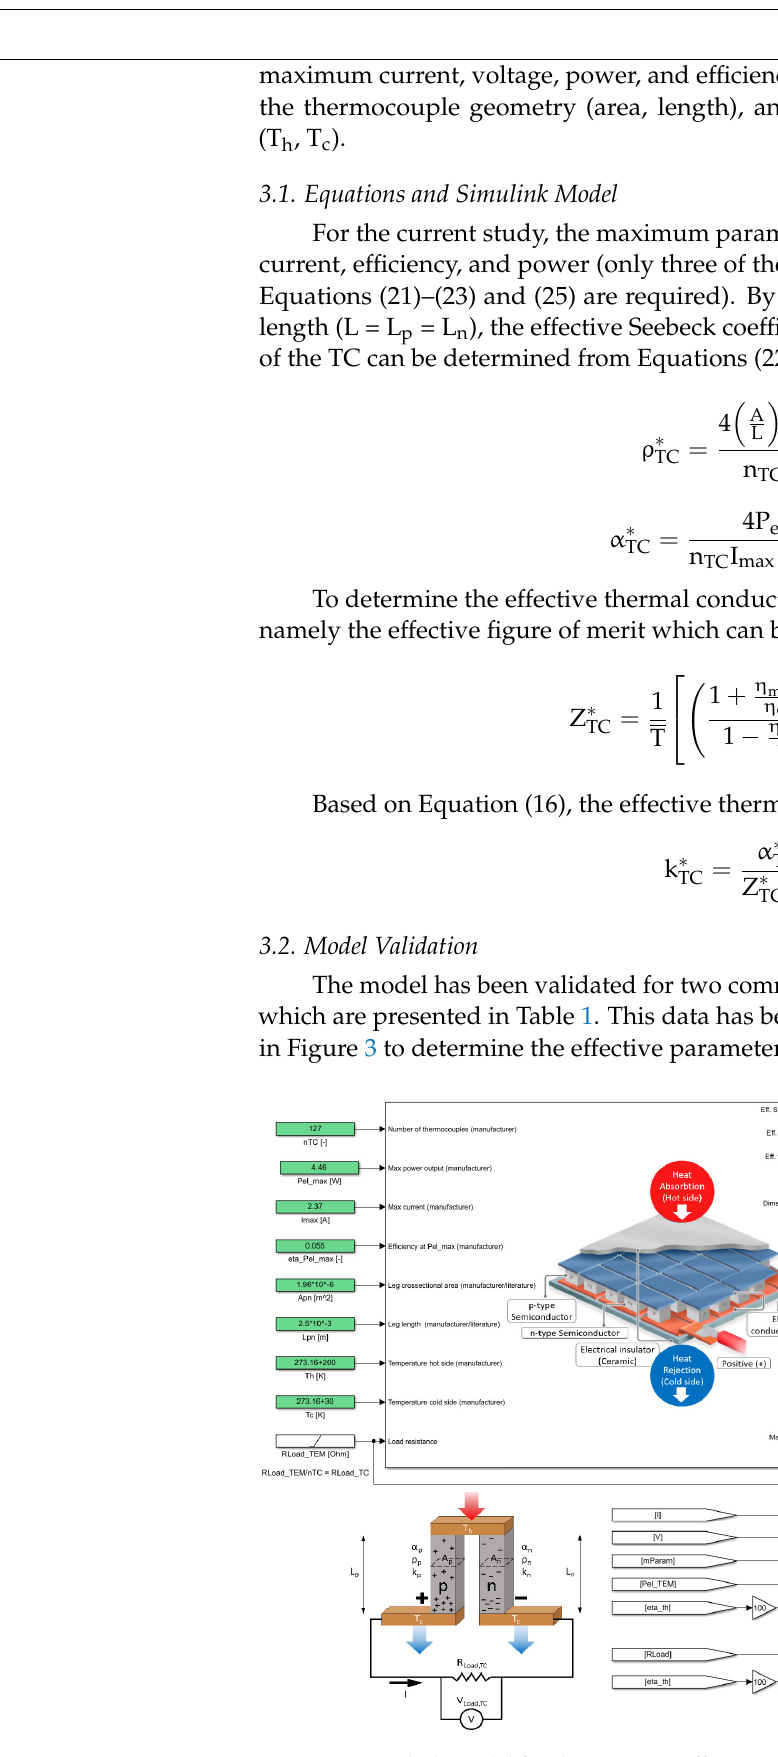
Figure 3. Simulink model for determining effective properties (values for